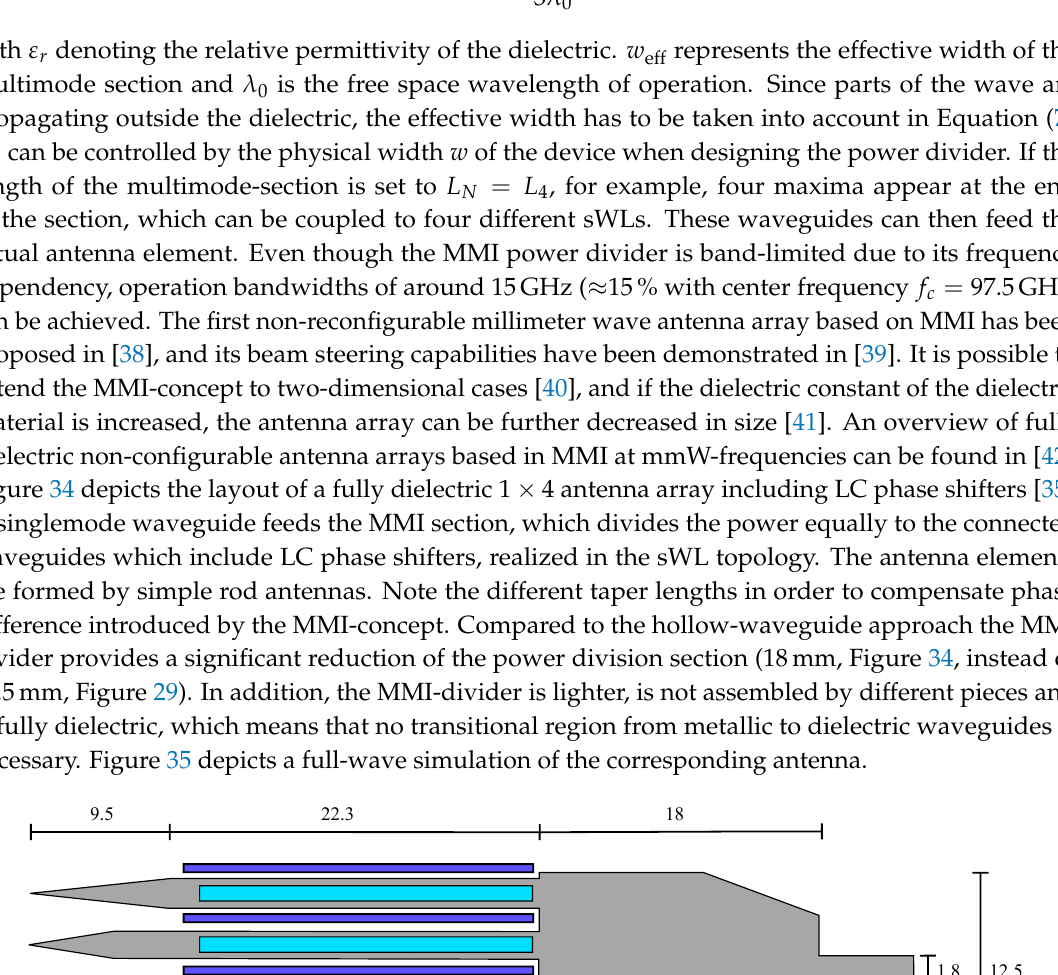
4 reconfigurable antenna array. All dimensions in mm ×